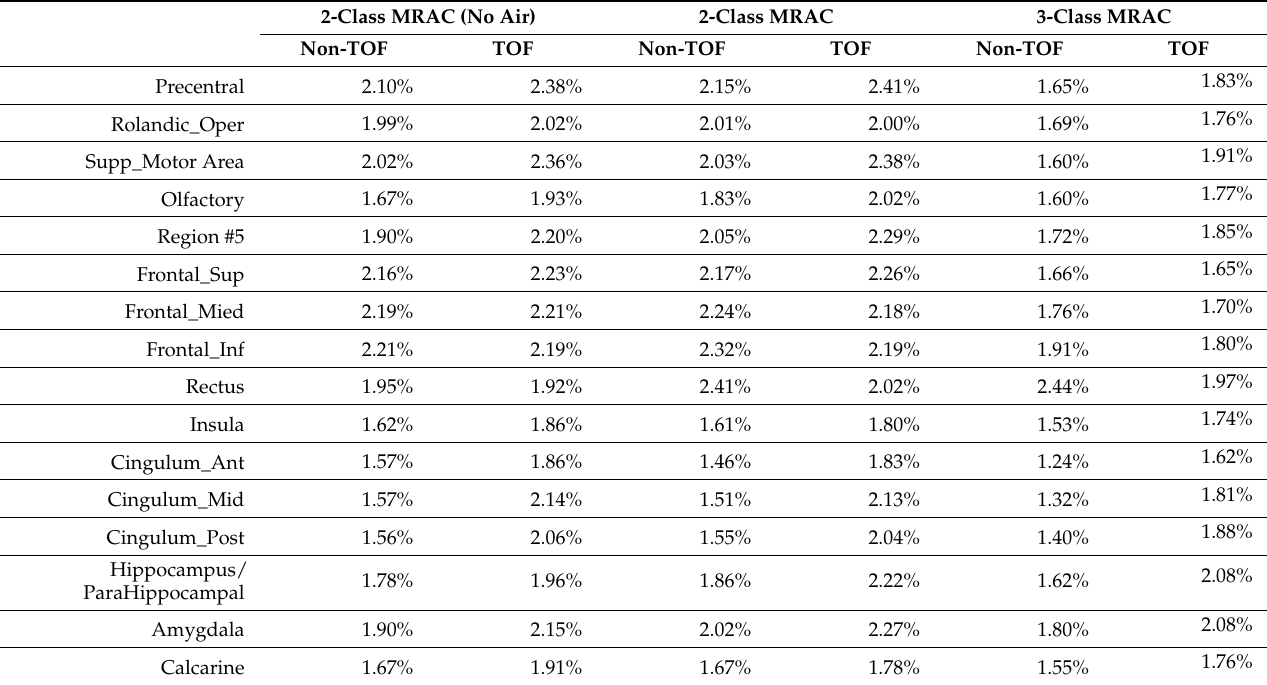
Table A2. The standard deviation of the bias across the brain regions with all attenuation maps with TOF and non-TOF